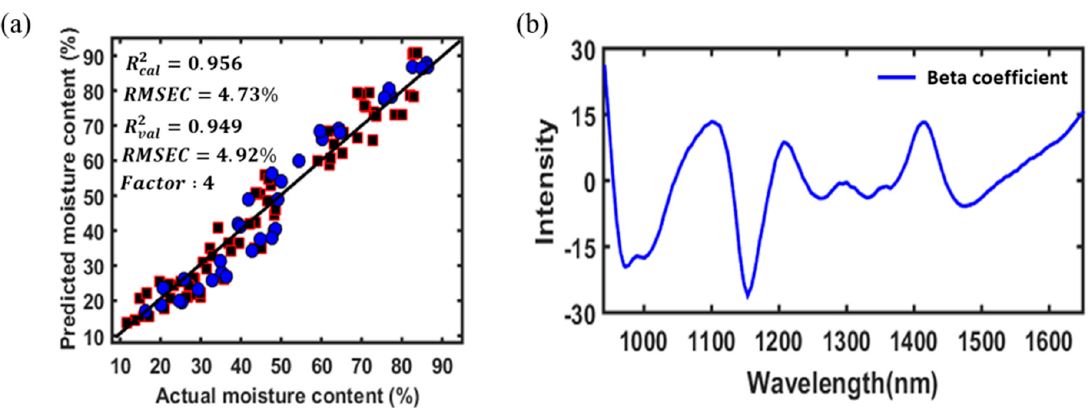
Figure 6. Regression plot from the partial least square regression (PLSR) model for calibration (squares) and validation (circles) sets developed with a spectral range between 960 and 1680 nm ( a ), and the regression coefficient of the PLSR model ( b ).